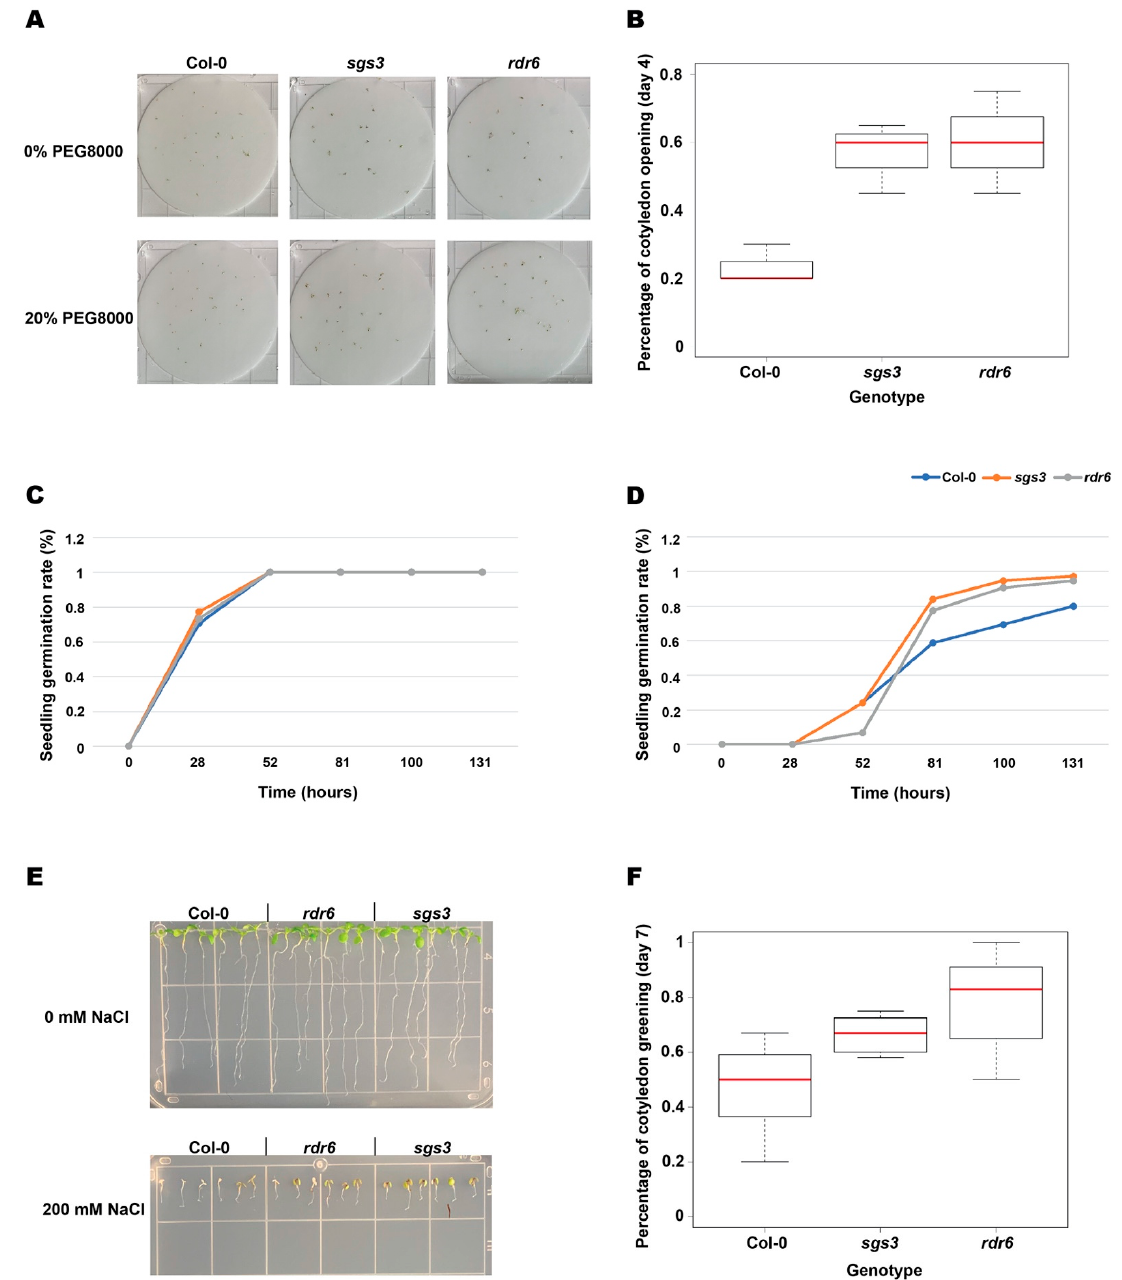
Figure 4. Results show rdr6 and sgs3 are less sensitive to PEG8000 and salt treatment. ( A ) Representative images of seedlings of the indicated genotypes grown without ( upper ) or with 20% PEG800 treatment in solution ( lower ) for four days. From left to right, the genotypes are Col-0, sgs3 , and rdr6 . ( B ) Percentage of cotyledon opening at day 4 with or without 20% PEG8000 treatment. The x -axis indicates the different genotypes, y -axis shows the percentage of cotyledon opening for each genotype. ( C , D ) The rate of seedling germination without ( C ) and with 200 mM NaCl (salt) ( D ) treatment. The x -axis of these graphs indicates developmental timing of the seedlings for the three genotypes, while the y -axis displays the percentage of germinated seedlings. Blue, orange, and grey lines denote Col-0, sgs3 , and rdr6 , respectively. ( E ) Respective images of seedlings of the indicated genotypes grown without (upper) or with 200 mM NaCl treatment (lower) for seven days. From left to right, the genotypes are Col-0, rdr6 , and sgs3 . ( F ) Percentage of cotyledon greening for seedlings of the three indicated genotypes after seven days of 200 mM NaCl treatment. The x -axis indicates the specific genotype, while the y -axis displays the percentage of seedlings with green cotyledons for each